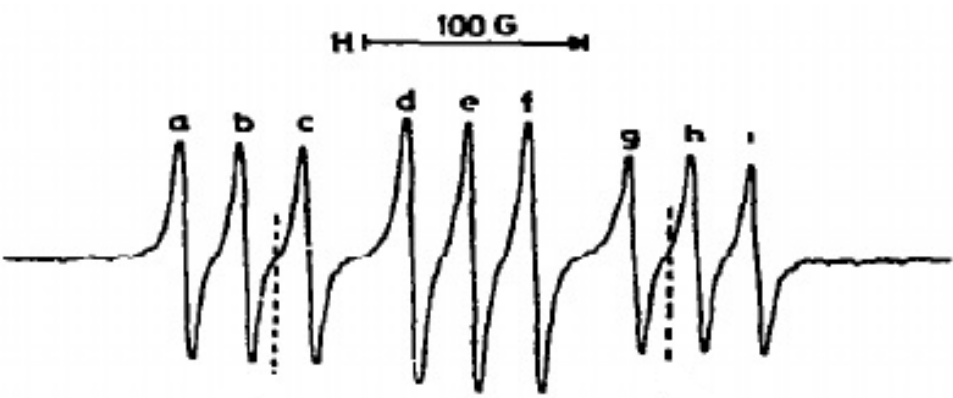
Figure 3. ESR spectrum of 2 NO ( 2 Π 3/2 ) at room temperature and pressure P NO = 0.5 Torr. Vertical dashed lines mark the central part of the spectrum. Adapted from ref. [10].